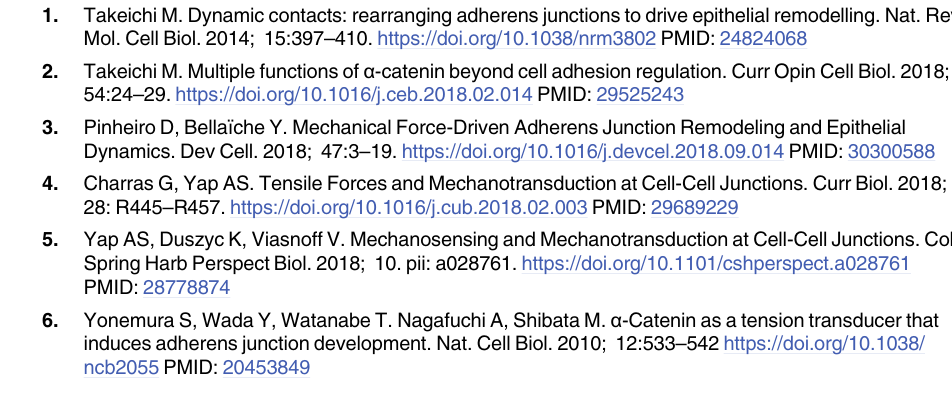
S1 Table. List of genotypes for all figures. S2 Table. α -Cat constructs used in this